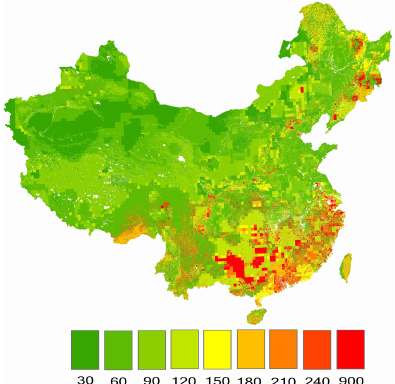
Figure 1. Updated Hg concentrations (ngg − 1 ) in surface soil (0– 20cm) of China. Sampling areas in NMPRGS cover most agri- culturally and industrially developed regions of East and Central China, and are presented in more detail in Li et al.